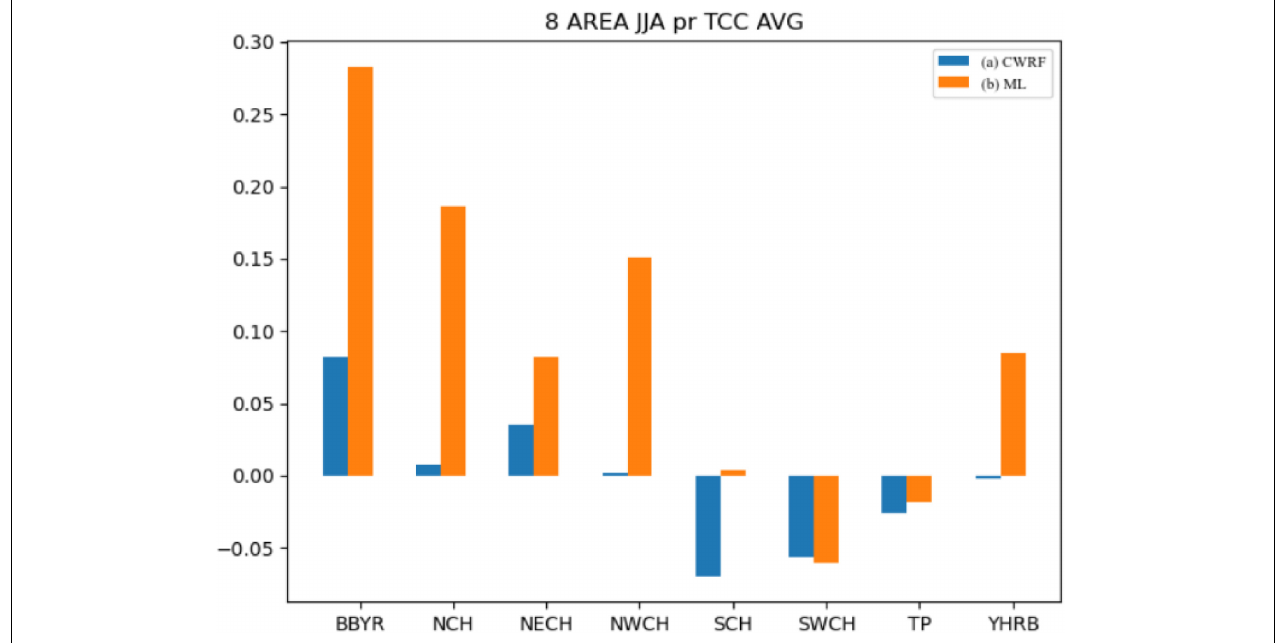
FIGURE 6 | Comparison of mean values of regional precipitation time correlation coefficients (CWRF vs. ML). (a) CWRF prediction and (b) machine learning correction.